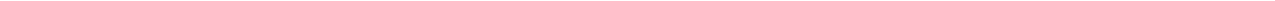
Fig. 3 Six3 + rostral polarization is governed by Fgf/FGFR/Mek signaling. a Immunostaining using a phospho speci fi c antibody against phospho (p)-tyrosine (Y) 724 FGFR3, showing pY724 FGFR3 with Six3::Venus signals in the day-3 and day-4 aggregates. b Schematics of gene expressions in day-3 and day-4 aggregates, and a timing of the addition of Fgf signaling antagonists (PD173074 and PD0325901) and agonist (bFGF). c , e Images of Fgf5::Turq and Six3:: Venus signals in day-4 aggregates with pharmacological inhibition of FGFR/Mek and stimulation of Fgf signaling from culture day 3 to 4. d Quanti fi cation of fgf5 expression via RT-qPCR. f Quanti fi cation of Six3::Venus + cells via FACS. g Schematic of a local application experiment. Recombinant bFGF was used as a global application. h Bright fi eld image of day-3.3 aggregate with a local bead. i Bright fi eld images of day-4.3 aggregates with local beads soaked in either DMSO or FGFRi. j Six3::Venus fl uorescent images of day-4.3 aggregates. Bottom panels are high magni fi cation images of insets of upper images. Arrowheads (Magenta) indicate salt and pepper-like Six3 + cells in the DMSO condition where Six3::Venus + signals are enhanced via the auto contrast function of ImageJ software to see a dim expression. k A graph shows the ratio of rostral polarization in the DMSO ( N = 137) and FGFRi ( N = 283) conditions. Polarized, Six3::Venus + signals were polarized. Salt and pepper, Six3::Venus + cells showed a salt and pepper pattern. Not polarized, Six3::Venus was globally expressed. l Schematic of the addition (only from day 3 to 4) and washout (at day 4) of PD173074, PD0325901 or bFGF. Below, merged images of transillumination (Trans) and fl uorescence of day-7 aggregates in each condition. m Quanti fi cation of Six3::Venus + and Irx3::Tomato + cells via FACS. Error bars indicate s.e.m of each experiment ( d , f , k , m ). Signi fi cance was determined using Dunnett ’ s test ( d , f , m ) and unpaired t -test ( k ). * P < 0.05; ** P < 0.01; *** P < 0.001. Cont, Control. Scale bars, 100 µ m ( a , c , e , h , i , j , l ). These images were one of n = 3 experiments ( a , c , e , h , i , j , l